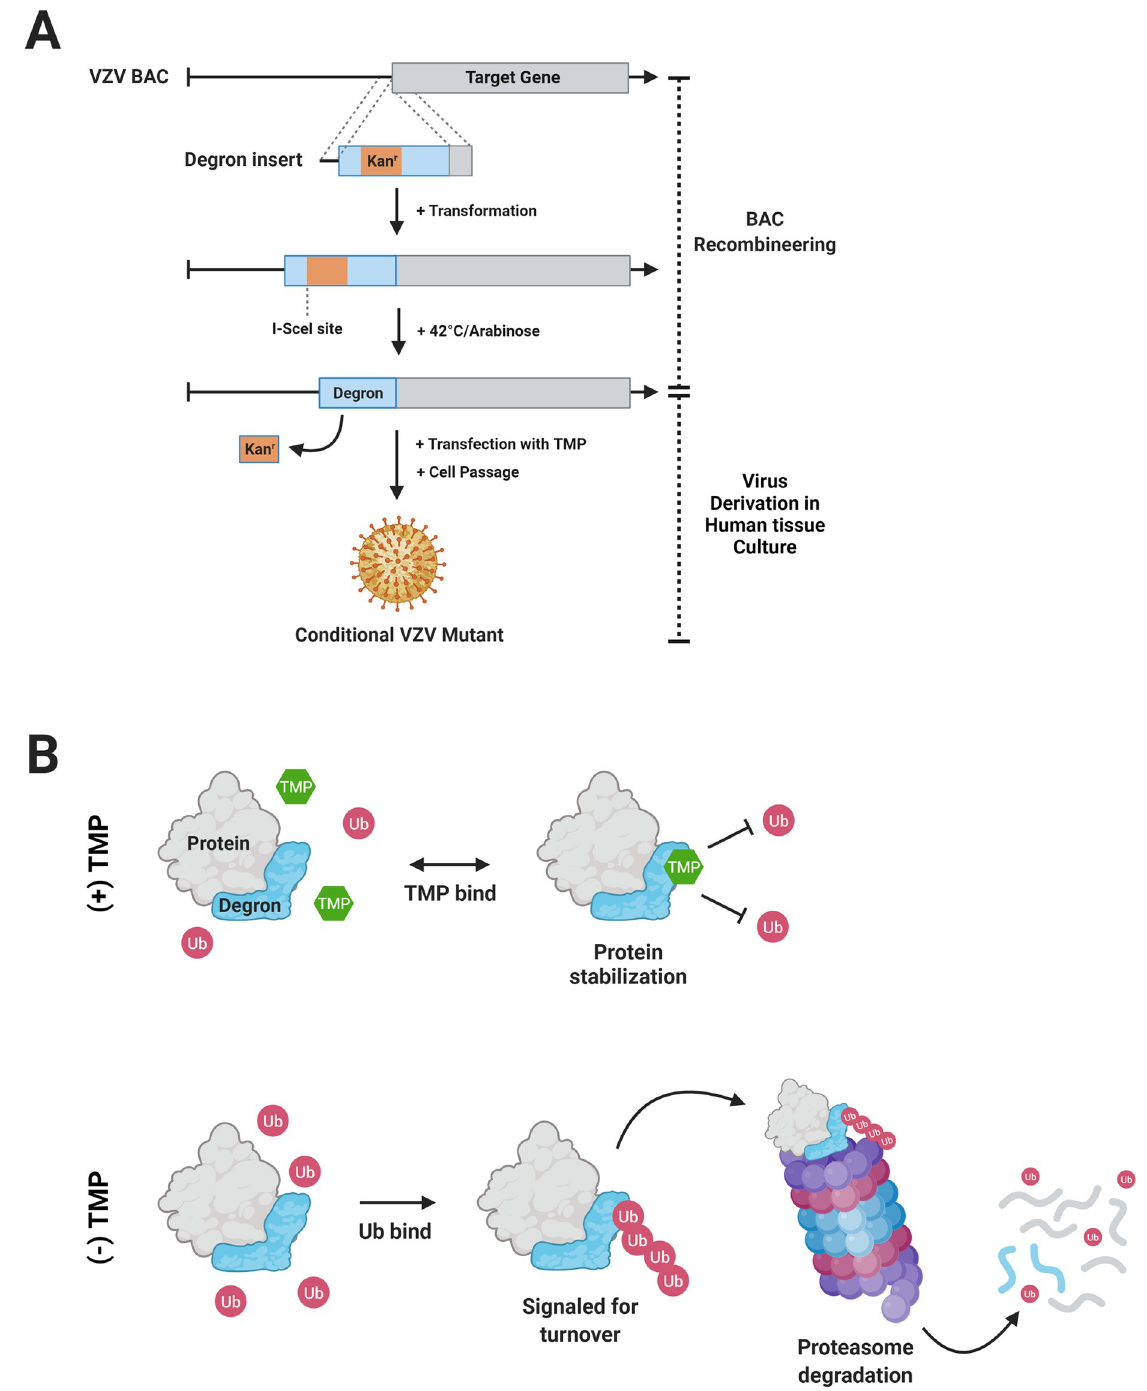
Fig 1. Overview of VZV BAC development with a degron insertion and TMP-dependent protein turnover. (A) A target gene in the VZV BAC is engineered by recombining a degron sequence with an interrupting kanamycin resistance cassette (kan r ) that allows for positive selection in E . coli GS1783 as detailed in the methods. A second induced recombination event in conjunction with expression of the homing endonuclease I- Sce I results in markerless excision of the kan r cassette, so that the degron coding protein is fused to the target gene ORF. BACs are then transfected into human TRPE cell monolayers in the presence of the stabilizing ligand trimethoprim (TMP) to yield infectious VZV. (B) In the presence of TMP (top), TMP (green) is thought to bind the degron and prevent ubiquitin (Ub, red) ligation, thus stabilizing protein and halting turnover. In the absence of TMP (bottom), Ub is ligated to the degron, and the entire protein is targeted for degradation by ubiquitin-proteasome pathway. Created with BioRender.com.